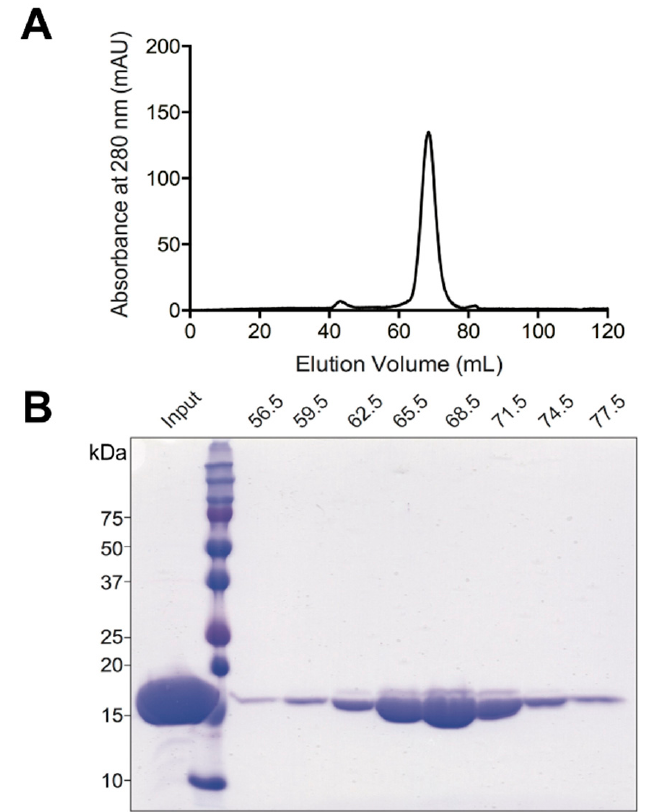
Figure 2. Purification of CaM. ( A ) Size exclusion chromatography of CaM: chromatogram of the size exclusion chromatography profile with absorbance at 280 nm displayed; ( B ) 15% SDS-PAGE of the resultant fractions showing purity of final CaM compared to input. e ffi cient capture on biosensor chips via anti GST-antibodies (Figure 3A). GST-tagged full-length Grb7 was overexpressed in Escherichia coli and purified as previously described, generating protein to > 95% purity (Figure 3B) [17]. To determine the requirement of the RA-PH region of Grb7, a GST-tagged construct that spanned the central RA and PH domains of Grb7 (residues 98–353) was cloned from the full-length Grb7. The boundaries for this construct were designed based on the boundaries reported for the Grb10 RA-PH construct for which the X-ray crystal structure was determined [18]. In the case of the Grb10 RA-PH construct, four cysteine to serine point mutations were introduced to prevent aggregation. In light of this, two corresponding point mutations (C113S and C207S) that were predicted to be distal to the predicted CaM binding interface were introduced to the Grb7 RA-PH